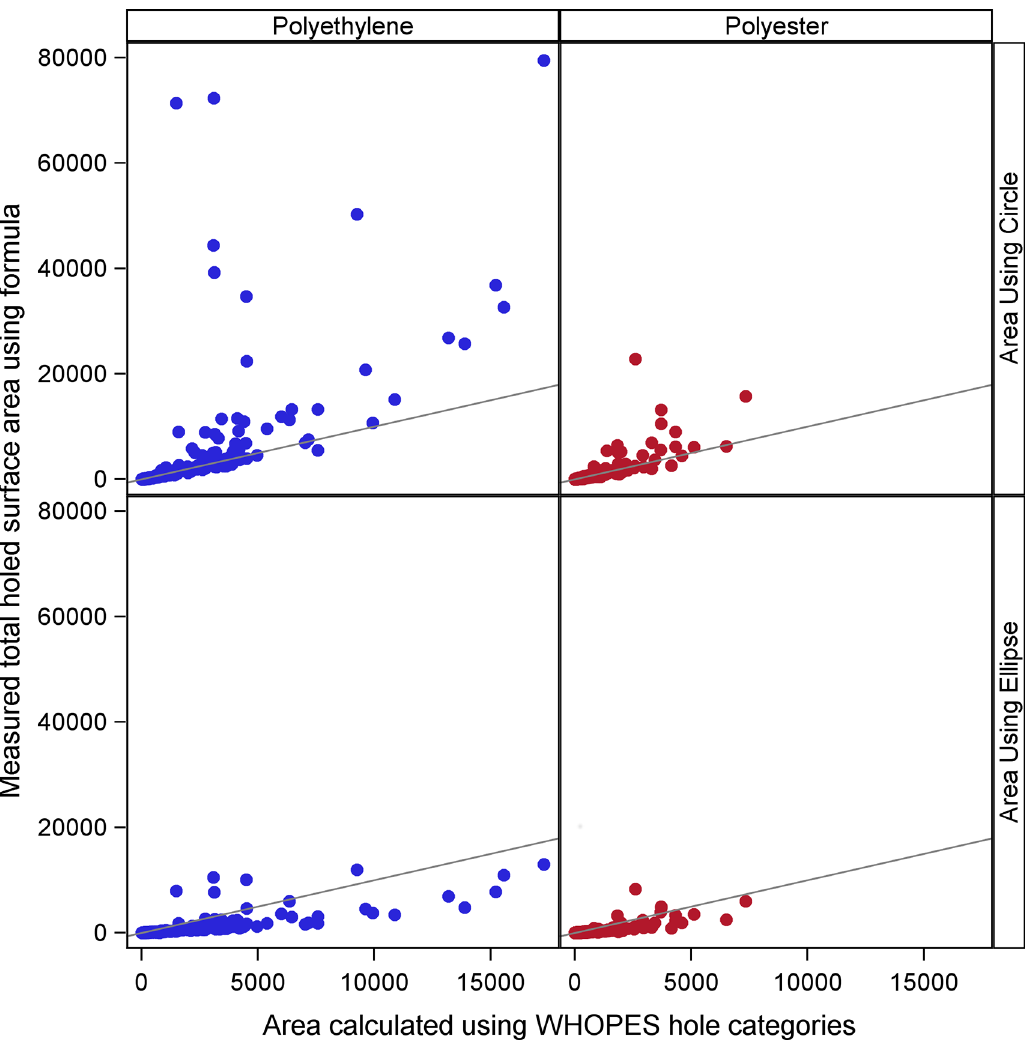
Fig 3. Scatterplot of surface area calculated using WHOPES Proportional Hole Index categories vs measured total holed surface area of net using A) formula of a circle, and B) formula of an ellipse by net type. Each point represents one net. The black lines represent the diagonals. Polyester nets: 100 denier, traverse [3.5.50], Polyethylene nets: 150 denier, tulle